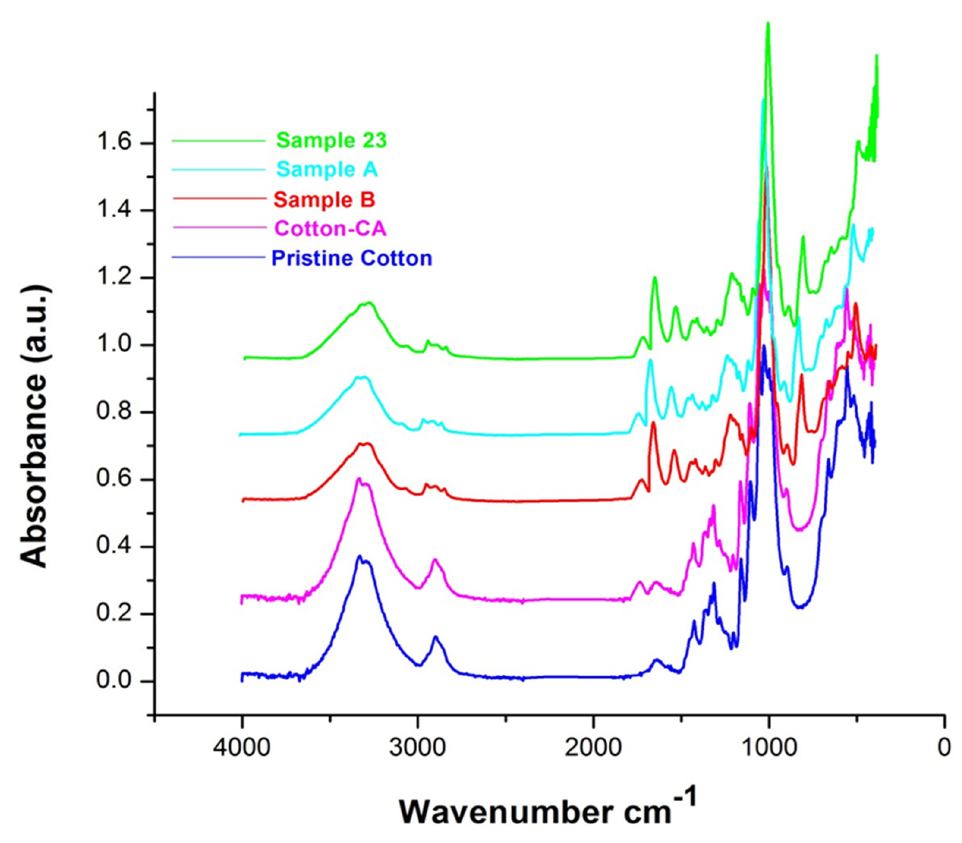
Figure 5. FTIR spectra of pristine cotton and sample A, sample B, and sample 23.